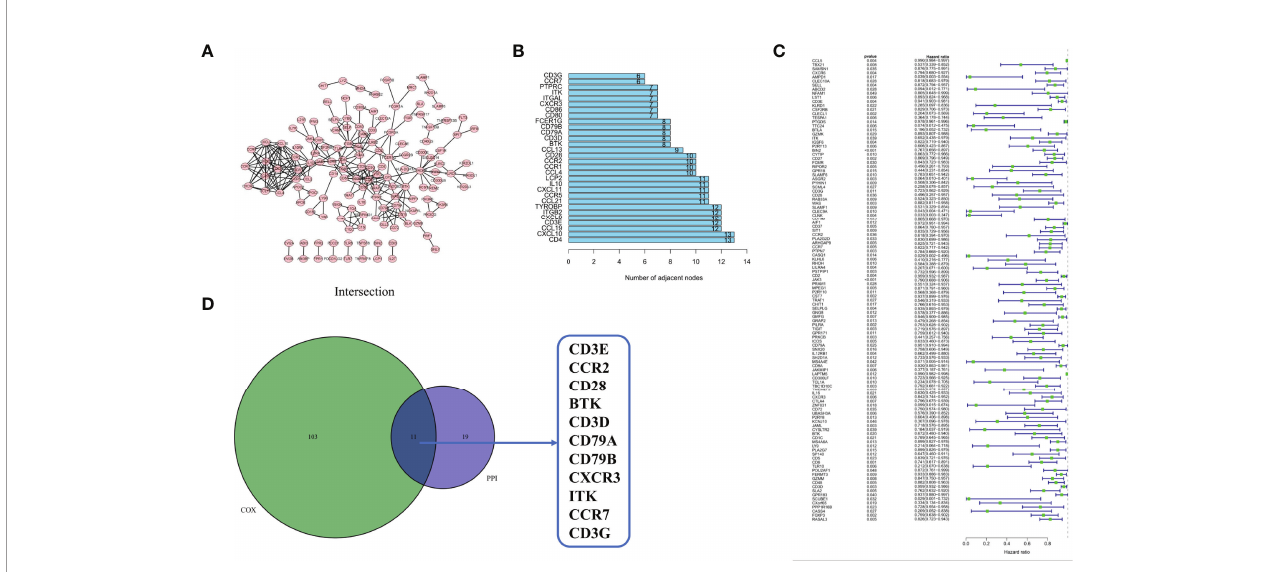
FIGURE 5 | Protein – protein interaction network and univariate COX. (A) Interaction network constructed with the nodes with interaction con fi dence value > 0.95. (B) The top 30 genes ordered by the number of nodes. (C) Univariate COX regression analysis with 425 DEGs, listing the top signi fi cant factors with p < 0.05. (D) Venn plot showing the common factors shared by leading 30 nodes in PPI and top signi fi cant factors in univariate